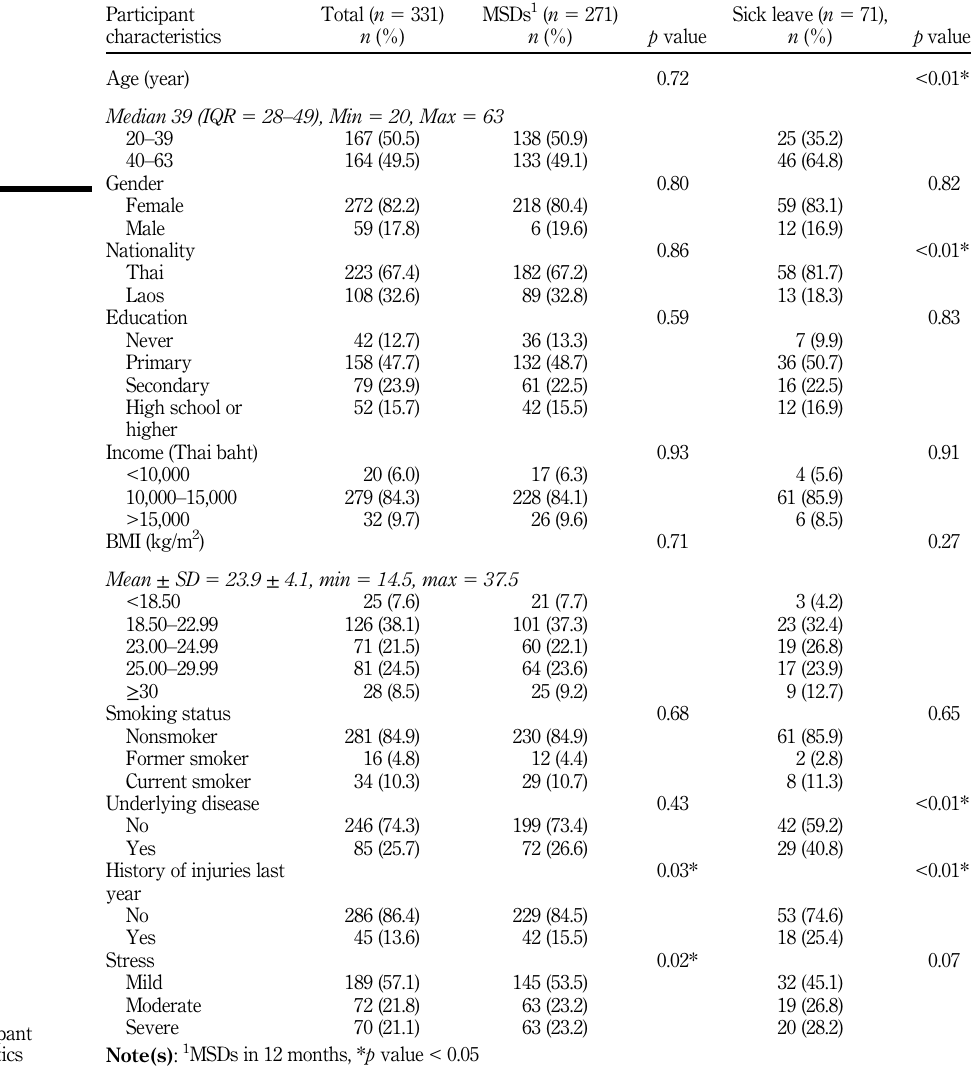
95% CI [1.13, 6.54] respectively. Moderate forward bending of the back during mopping increased the risk of MSDs (OR 5 2.81, 95% CI [1.43, 5.50]). Moreover, performing tasks continuously for 2 h or more was another risk factor for MSDs: OR 5 1.90, 95% CI [1.01, 3.57] for 2 – 4 h, and OR 5 3.39, 95% CI [1.17, 9.86] for more than 4 h (Table 4). Similar to 12-month MSDs, sick leave was significantly associated with a history of injuries (OR 5 2.27, 95% CI [1.12, 4.67]), Thai nationality (OR 5 2.03, 95% CI [1.04, 3.98]) and having another part-time job (OR 5 4.31, 95%CI [1.37, 13.57]) (Table 5).